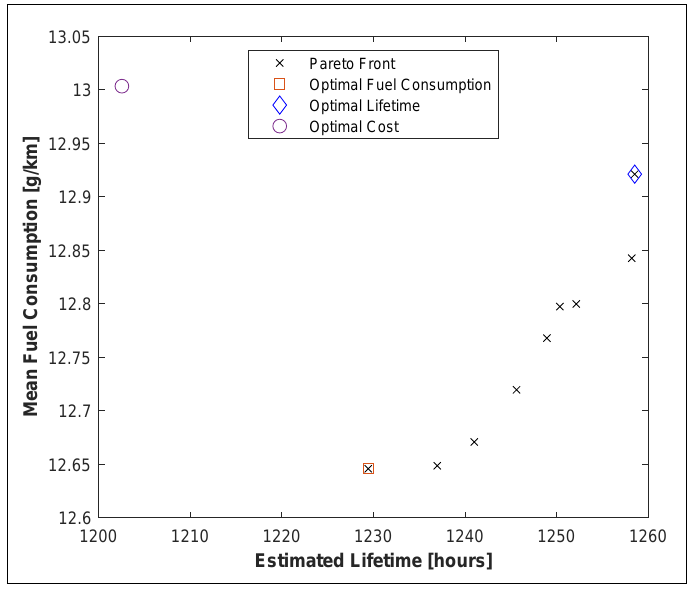
Figure 11. Pareto curve of fuel consumption vs. fuel cell